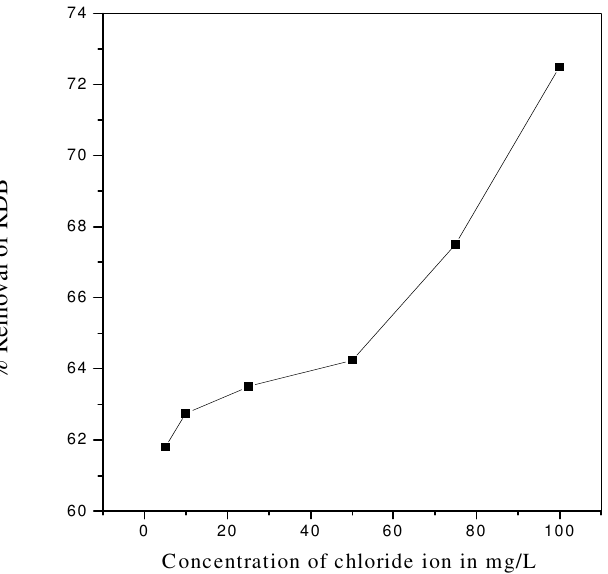
Figure 7 . Effect of ionic strength on the adsorption of RDB by